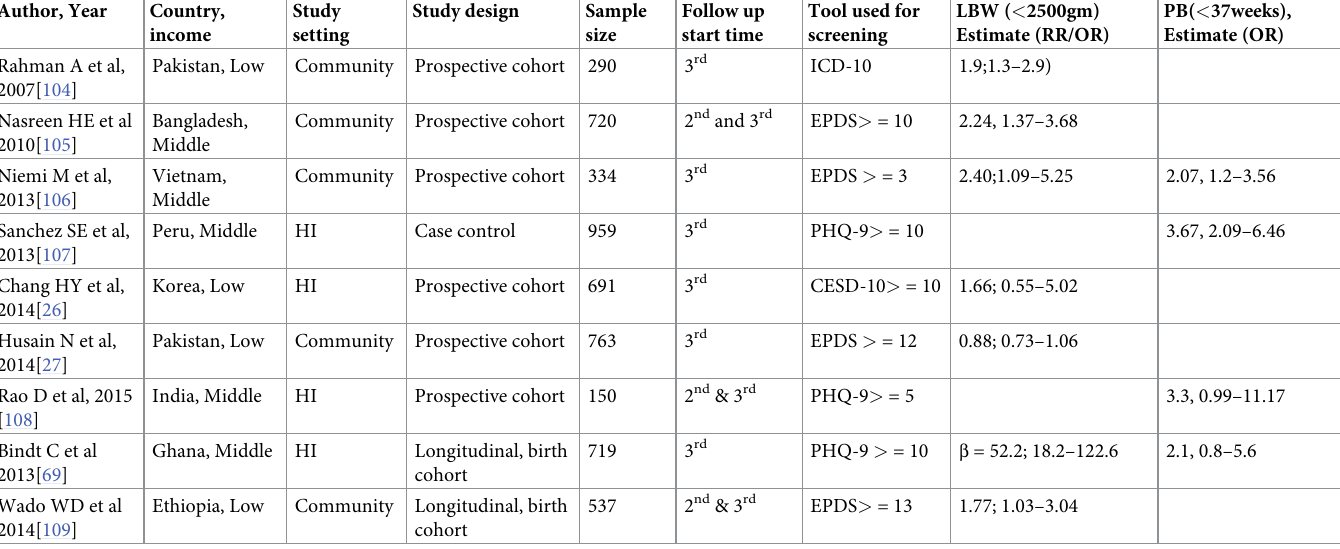
Table 4. Summary of studies conducted on the association of antenatal depression with adverse birth outcomes in the low and middle-income countries, (N = 9, in the year